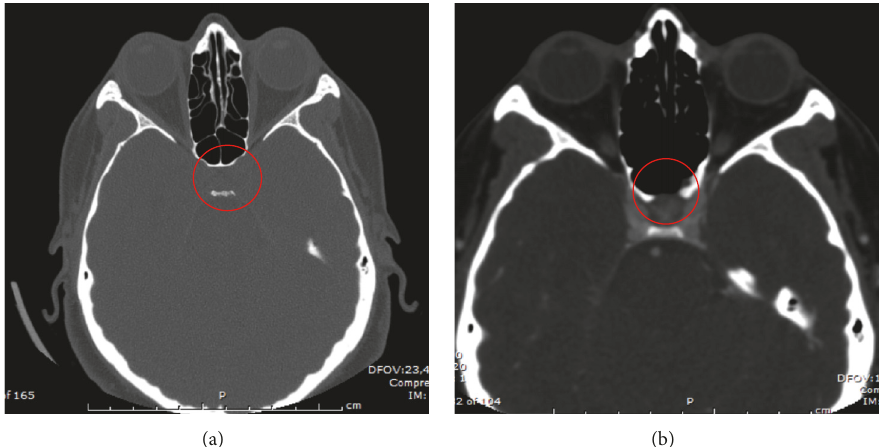
Figure 7: Case 4. (a) Preoperative CT scan showing a pituitary adenoma. (b) Seven-month postoperative CT showing a doubtful image of bony closure of the surgical